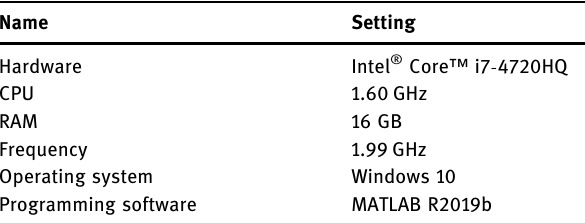
Table 1: The con fi guration of the system Name